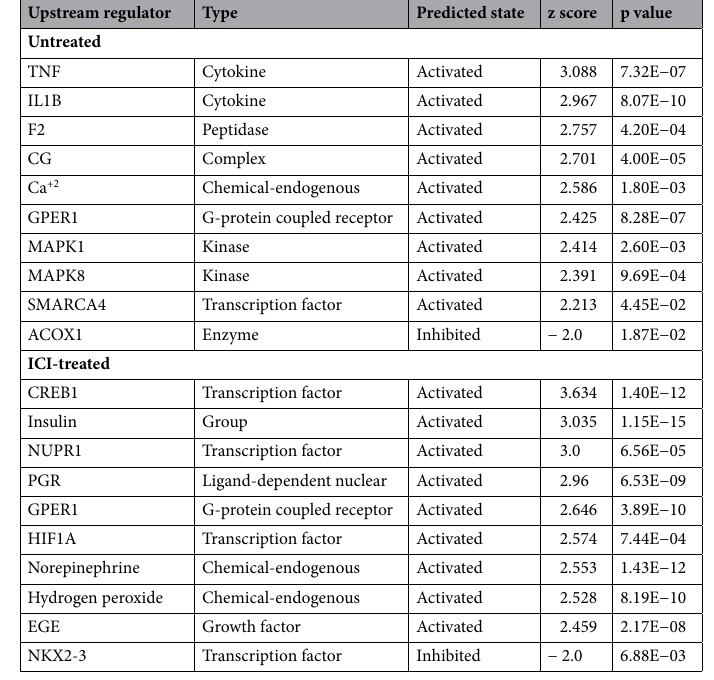
Table 3. Most altered endogenous upstream regulators identified in the heart by the Ingenuity Pathway Analysis based on the comparison of stressed with non-stressed untreated rats (4 rats/group), and those stressed and unstressed treated with ICI118,551 (4 rats/group). The thresholds were z score (≥ 2 or ≤ -2) and p value (≤ 0.05). The list with additional information is available in Supplementary Table